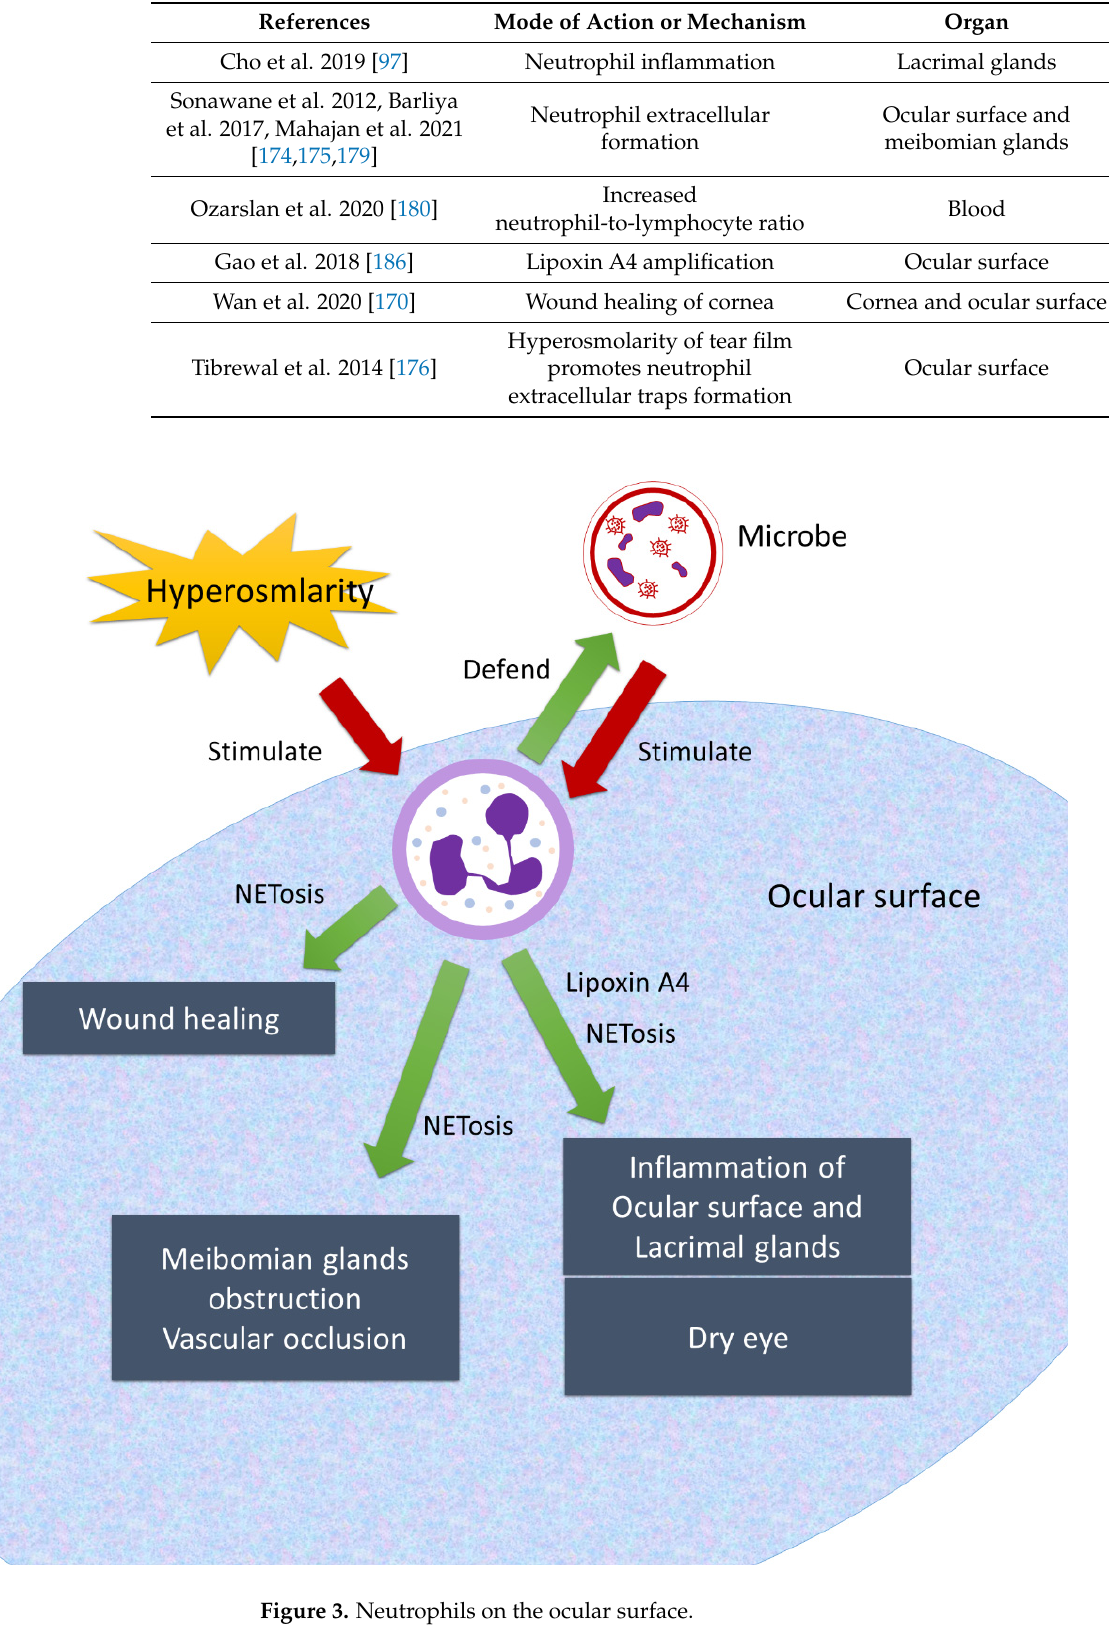
Table 2. Role of neutrophils on the ocular surface.